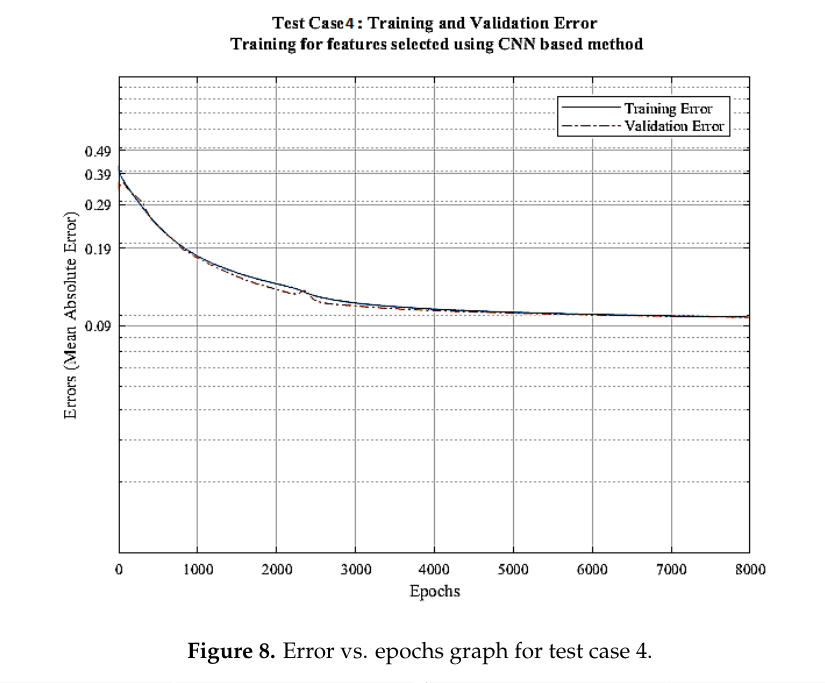
Figure 8. Error vs. epochs graph for test case 4.